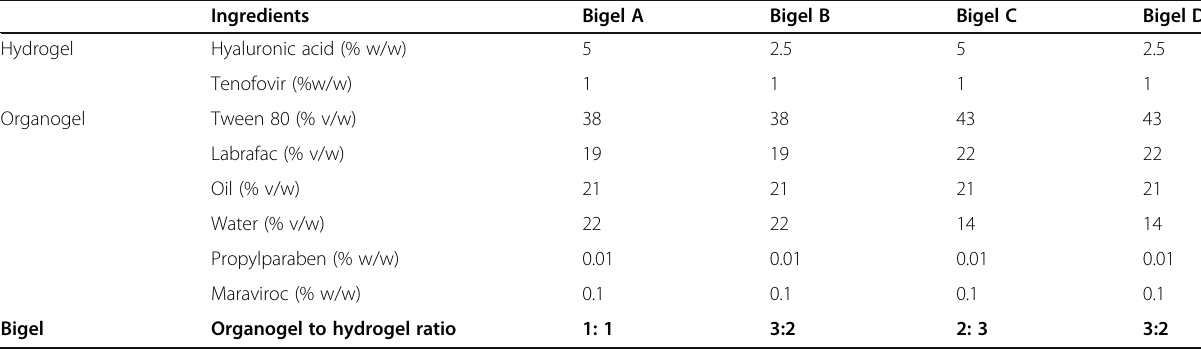
Table 1 Composition of tenofovir and maraviroc bigel formulations Ingredients Bigel A Bigel